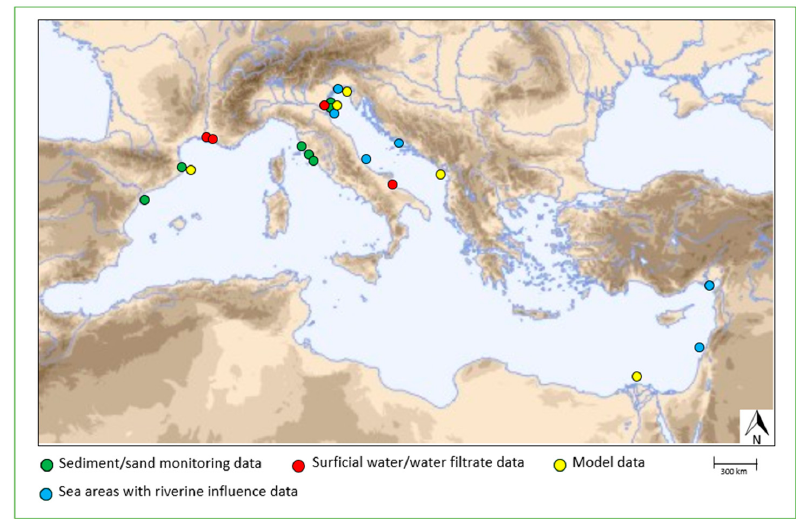
Figure 1. Map showing the geographical locations for data available on microplastic contamination in Mediterranean tributary rivers .